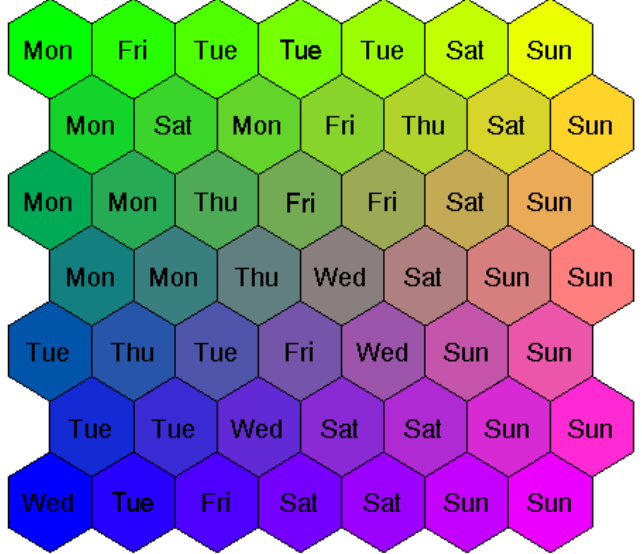
vectors representing the averaged day load patterns on the weekdays. The 24-h power demand vectors have been grouped in clusters of similar load patterns. The 24-h load patterns corresponding to Saturdays and Sundays create clusters on the right side of the image. The other (working) days from Monday to Friday are grouped on the left and are not interlaced with the weekend days.